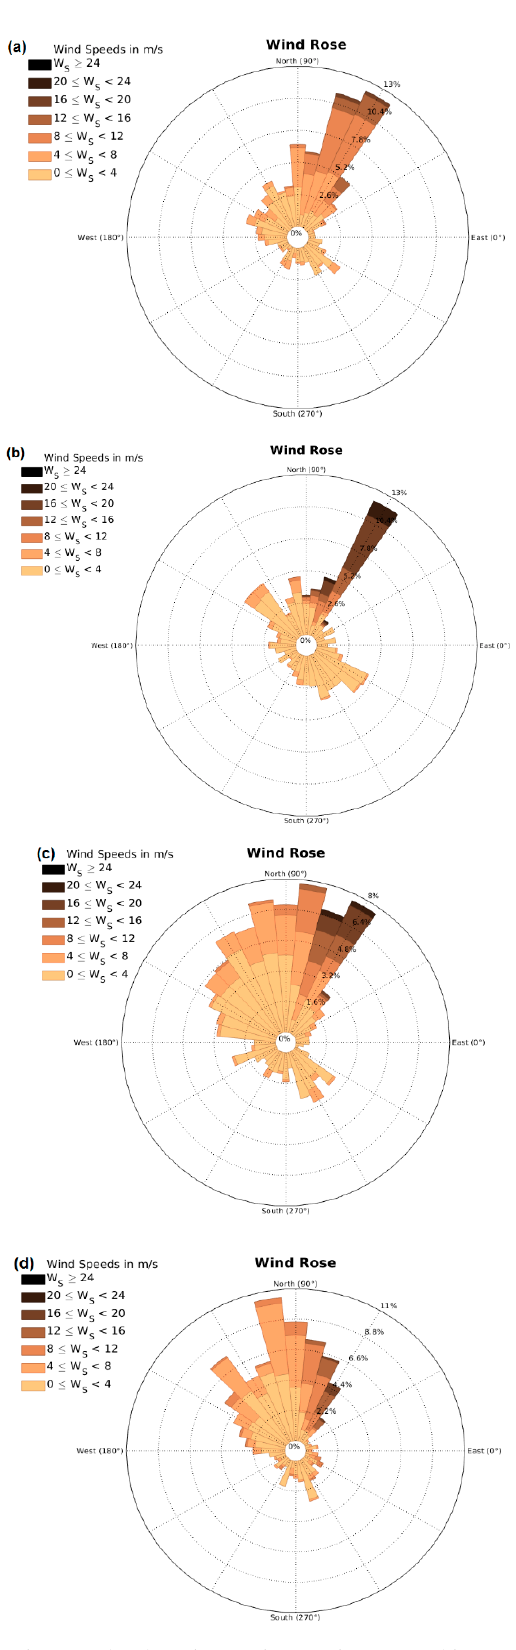
Figure 7. Wind speed distributions (m/s) in the northern Adriatic Sea (the northernmost area: the Gulf of Trieste) during ( a ) March 2007, ( b ) March 2008, ( c ) December 2007, and ( d ) December 2008. Colors in boxes show the selected range for the wind speed (m/s).